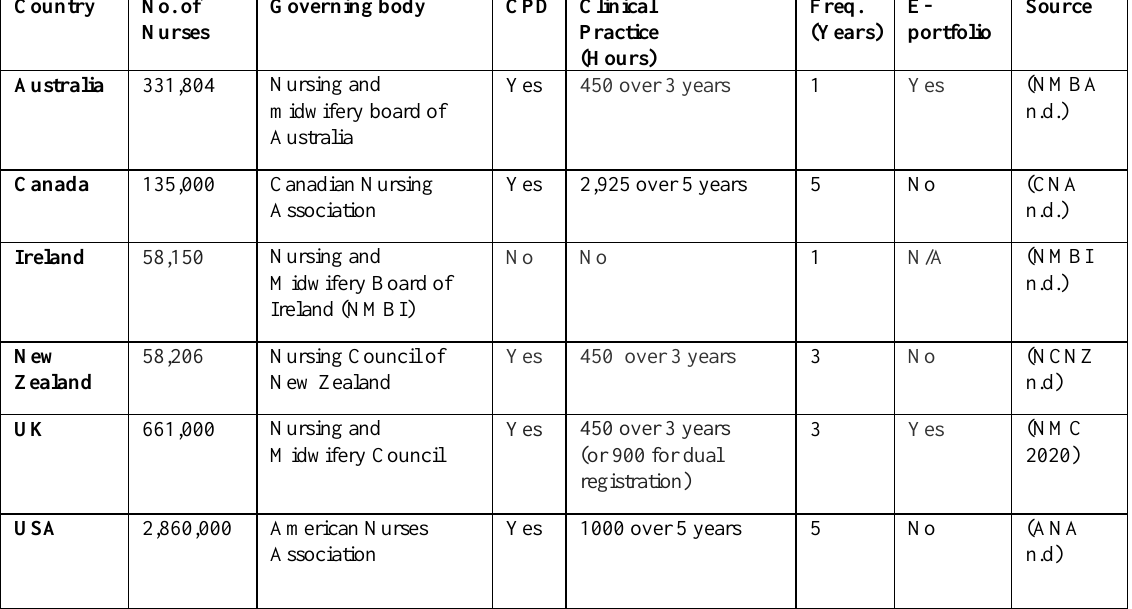
Table 1. Revalidation